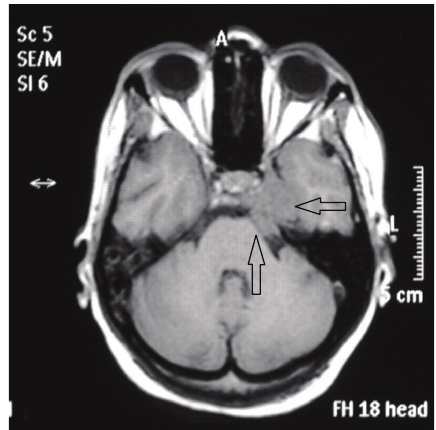
Figure 2: MRI precontrast showing altered signal intensity of the clivus, axial section that appears hyperintense.